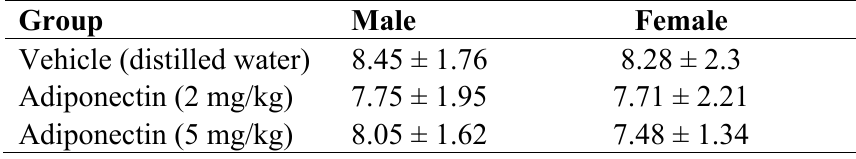
Table 4. Total white blood cell (WBC count (10 9